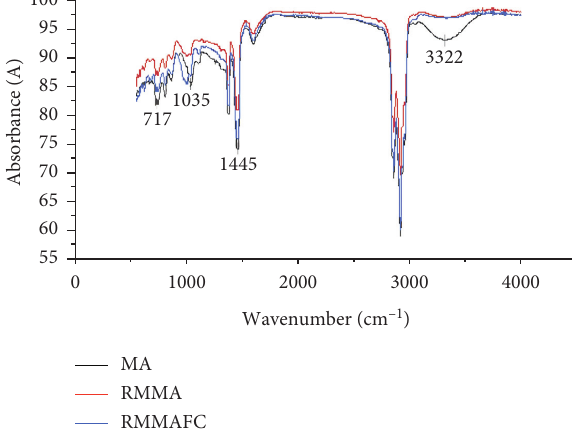
Figure 1: FTIR spectra of asphalt samples. Table 2: Group absorption position and vibration type.